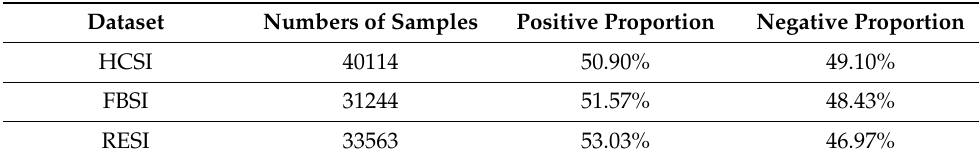
Table 1. Label distributions of three